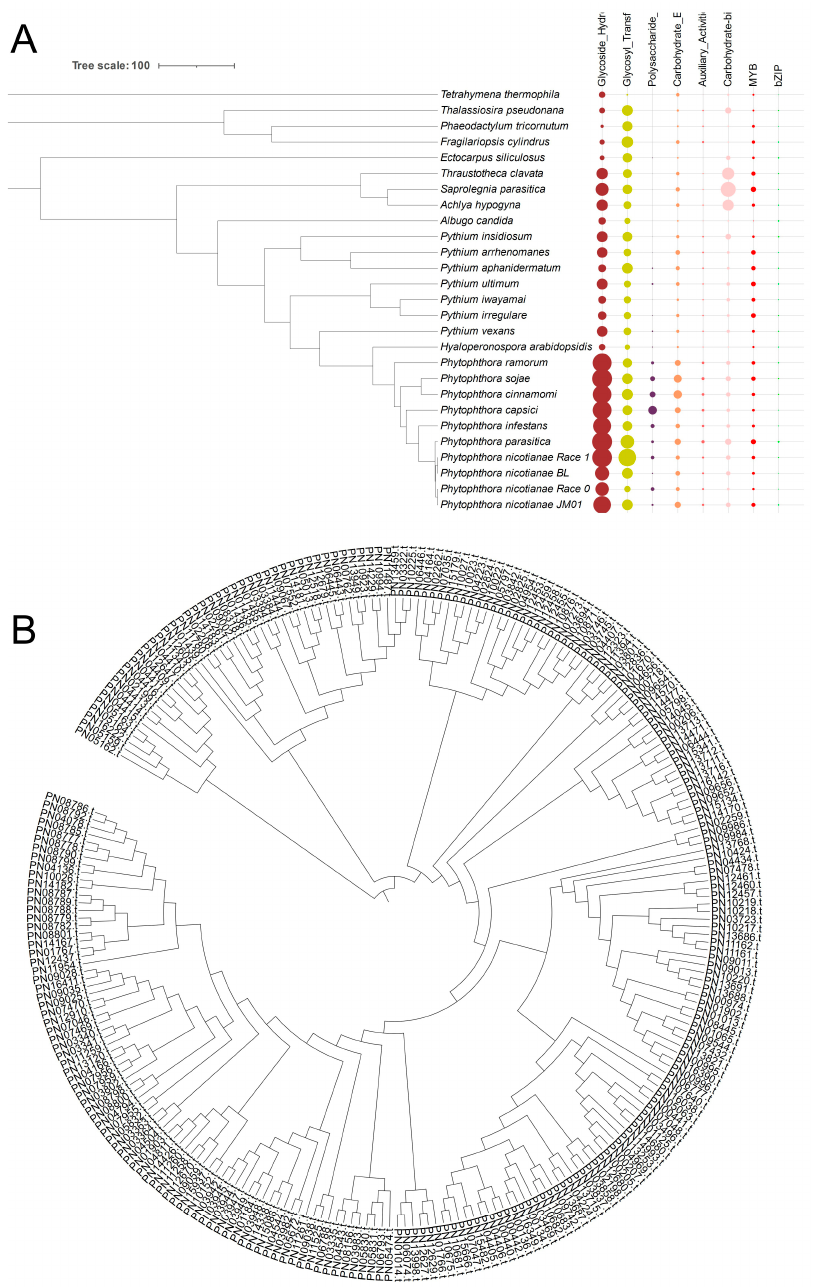
Figure 2. CAZyme annotation and transcription factors of Ph. nicotianae JM01 and other closely related genomes. ( A ) The CAZyme annotation and transcription factors results. The tree on the left was generated using Bayesian inference in BEAST v1.7.5. Different circles present glycoside hydrolases, glycosyl transferases, polysaccharide lyases, carbohydrate esterases, auxiliary activities, the carbohydrate-binding module, MYb and bZIP. The sizes of dots on the right present the gene numbers of different CAZyme genes and transcription factors. ( B ) Phylogenetic relationships of glycoside hydrolases (GH) genes in Ph. nicotianae JM01 .